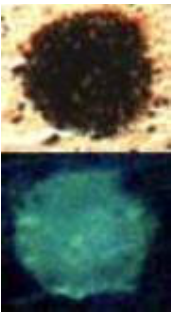
FIGURE 1. Congofilic plaque possessing TrpRS. Fibrils in TrpRS-possessing plaques were revealed by confocal microscopy. Synthetic peptide corresponding to N-terminal region (32-50 residues) of hTrpRS spontaneously aggregated and formed fibrils. These fibrils bound Congo Red and showed birefringence, whereas C-terminal peptide (414-437 residues) did not bind Congo Red and remained in